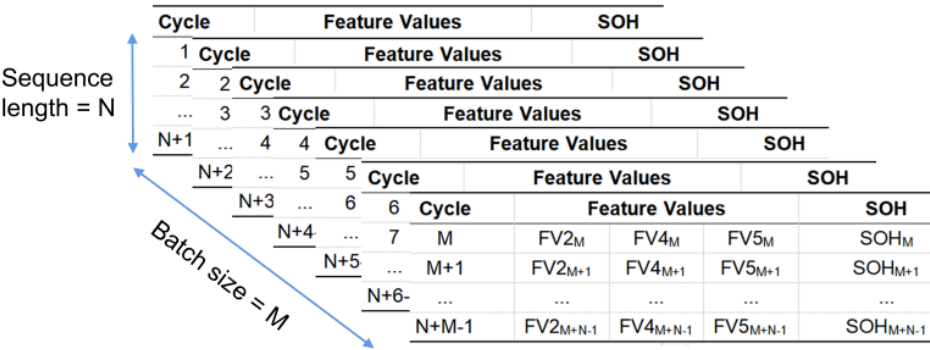
Figure 7. Timeseries construction of training dataset.